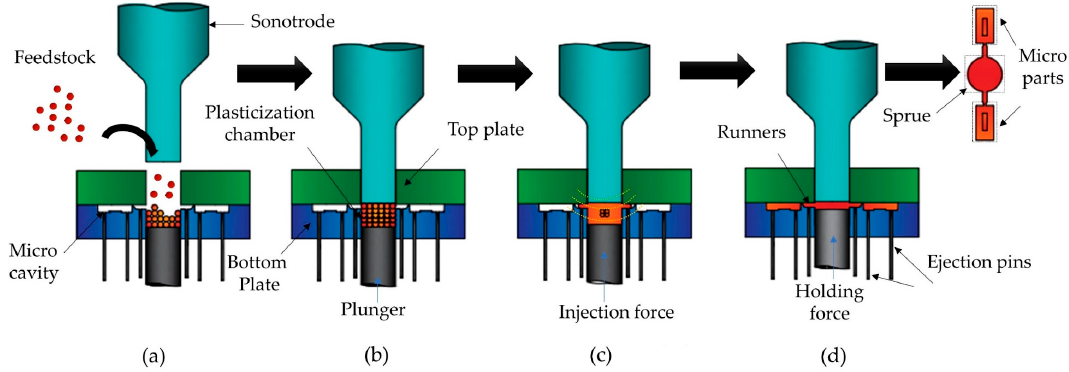
Figure 6. Schematic representation of the ultrasonic molding process. ( a ) Feeding; ( b ) Vibration initiation; ( c ) Plasticization and cavity filling and; ( d ) Holding stage and part release. Adapted from [18].